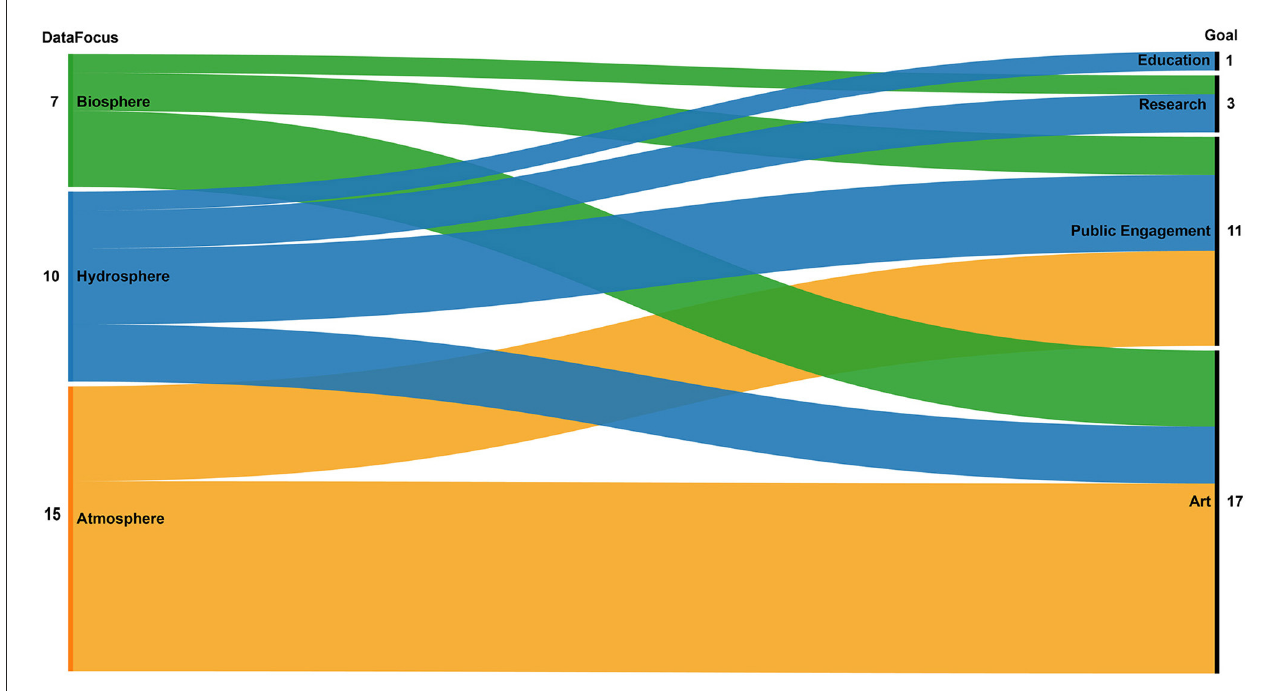
FIGURE6 Correlation between the three data foci (atmosphere, biosphere, and hydrosphere) and the goals of the selected projects.